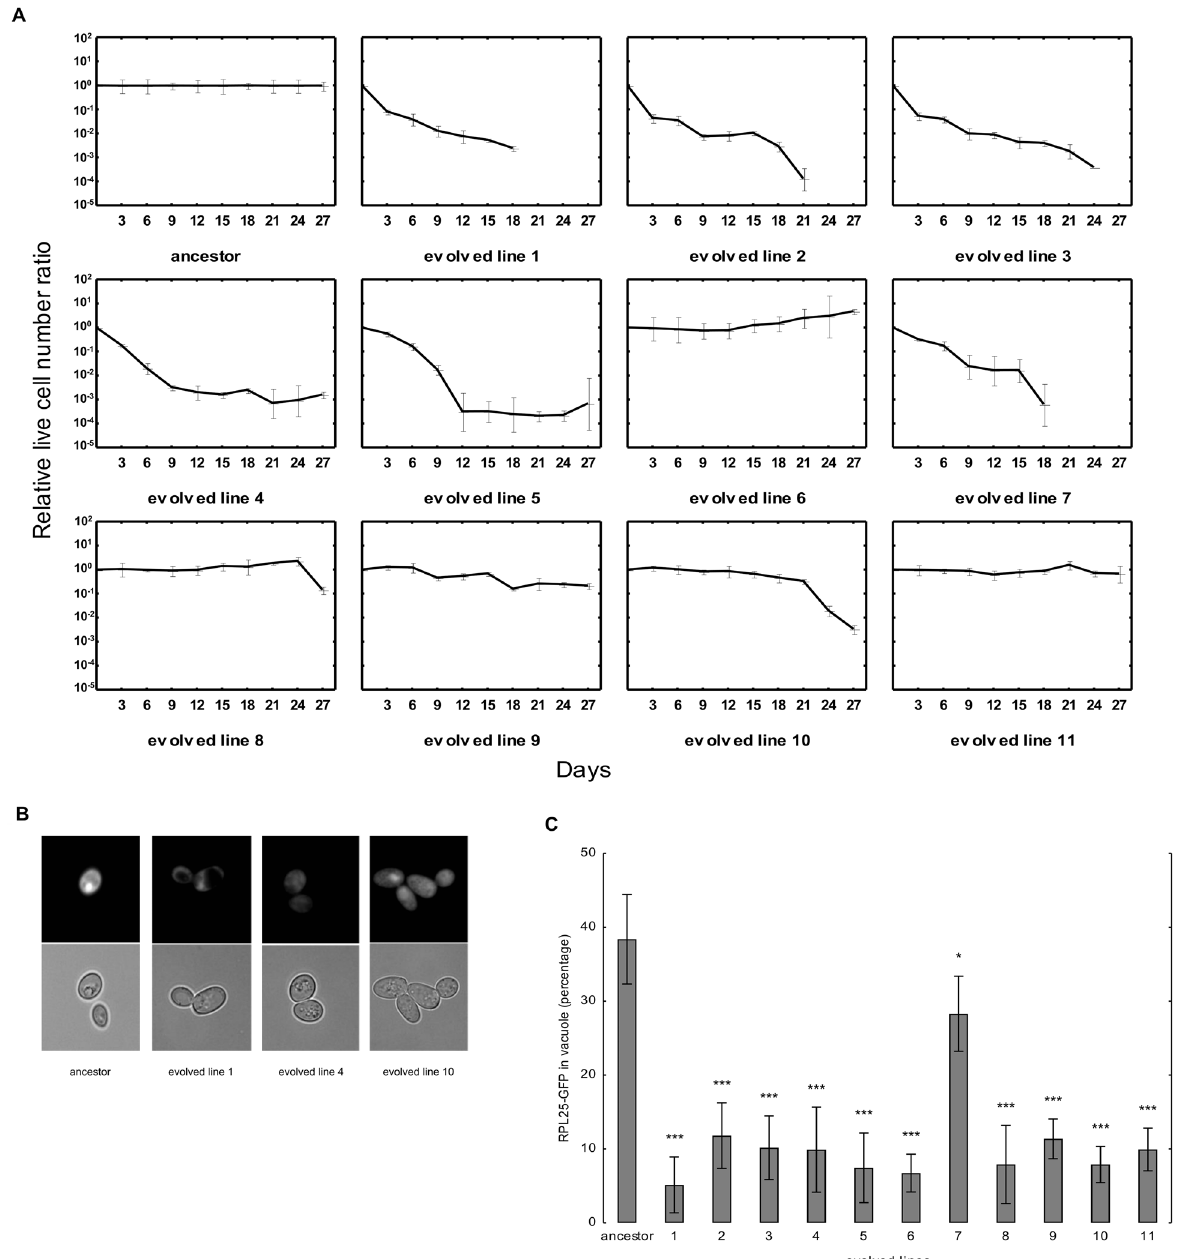
Fig 8. Side effects of adaptation to mistranslation. (A) Survival of the ancestor and the evolved lines upon prolonged starvation. Colony forming units were used as a proxy for live cell numbers. The colony forming units were counted every 3 d, and the ratio of live cells were calculated and normalized to the ancestor (upper left panel). The bars indicate mean ± 95% confidence interval. To ensure that changes in cell survival reflect the impact of the accumulated mutations (rather than the direct effects of mistranslation), tRNA CAGSer was swapped for the corresponding empty vector in the ancestor and in the evolved lines. (B) Distribution of Rpl25p-GFP in ancestor and evolved lines carrying tRNA CAGSer . (C) Rpl25p-GFP relocalization upon starvation in the ancestor and the evolved lines carrying tRNA CAGSer . Cells were grown to mid-log phase in starvation conditions for 24 h and were analyzed by epifluorescence microscopy. Cells with vacuolar fluorescence were manually counted. At least eight randomly chosen microscopic fields were counted, and approximately 100 cells per line were counted. The bars indicate mean ± 95% confidence interval. Mann-Whitney U test was used to assess the difference in Rpl25p-GFP relocalization between ancestor and evolved lines. *** indicates p -value <